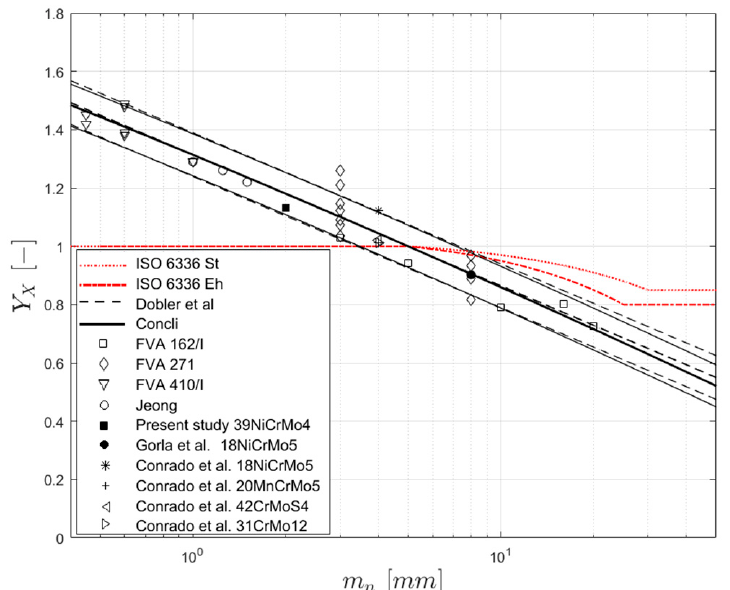
Figure 4. Gear size factor vs.